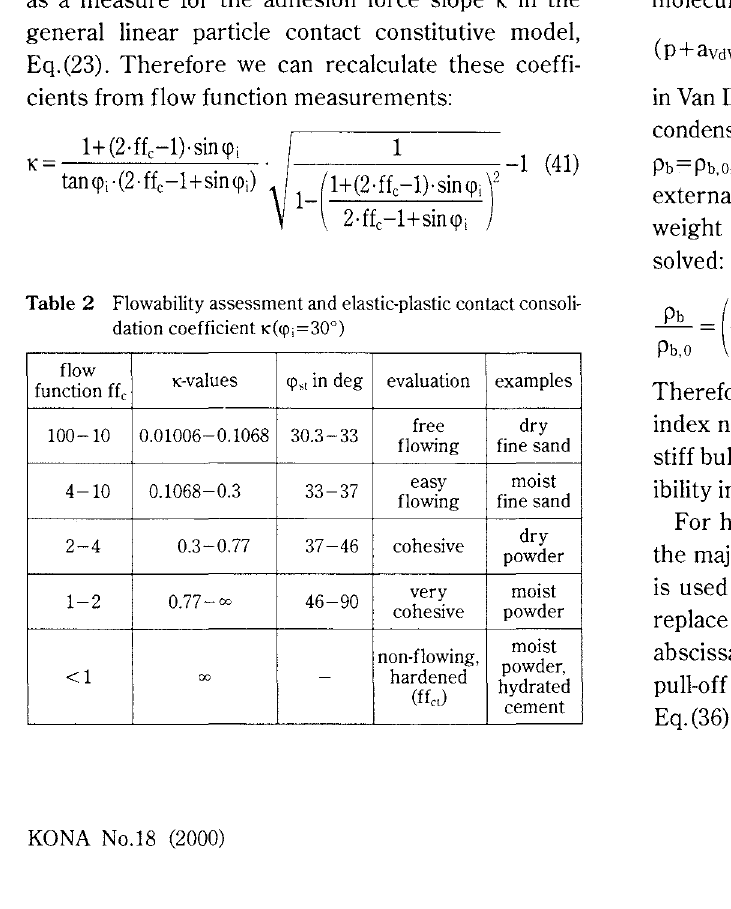
Table 2 Flowability assessment and elastic-plastic contact consoli dation coefficient